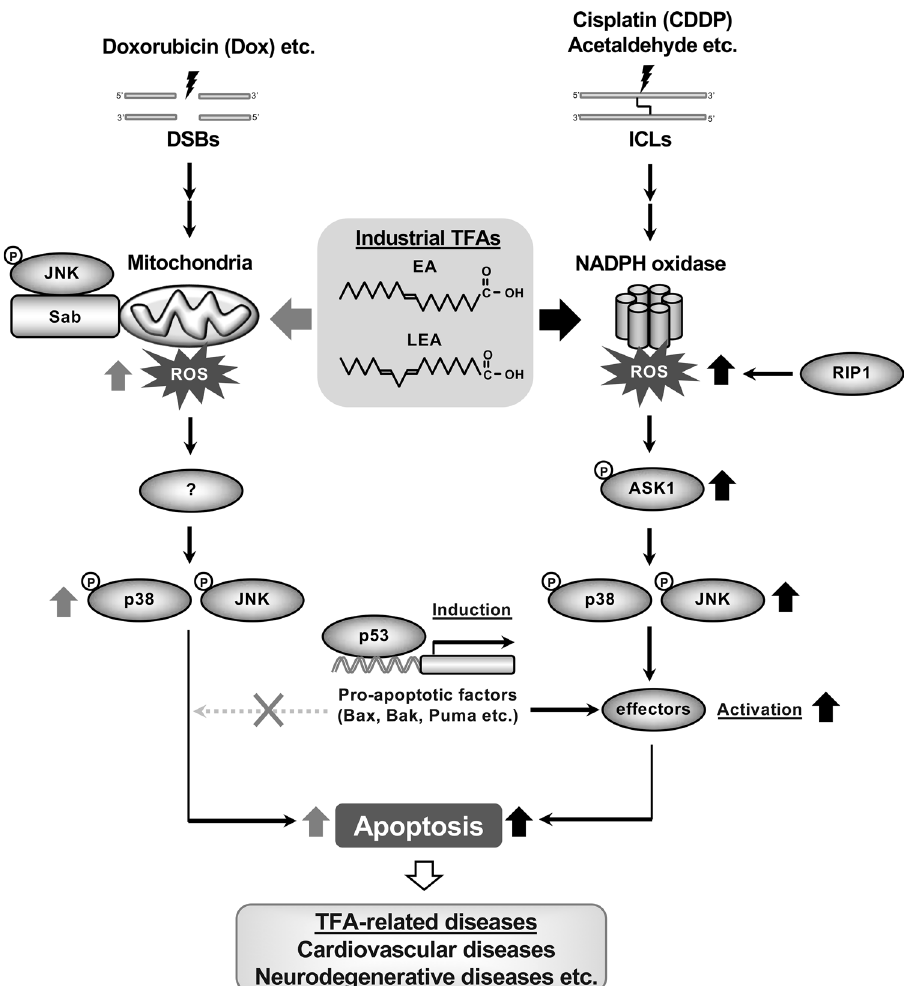
Figure 6. A schematic model for two distinct EA-mediated pro-apoptotic signaling pathways in response to DNA damage. Industrial TFAs such as EA and LEA promote cell death triggered by Dox (a DSB-inducing agent) and CDDP (an ICL-inducing agent) through two distinct pro-apoptotic signaling pathways. Upon Dox exposure, TFAs enforce mitochondrial ROS generation via the mitochondrial JNK-Sab (a JNK adaptor protein localized at outer membrane of mitochondria) axis, which in turn enhance JNK/p38 MAPK activation, and consequently promote apoptosis independently of ASK1 and p53 12 . On the other hand, upon CDDP exposure, TFAs drive Nox/RIP1-dependent ROS generation, and thereby enhance activation of the ASK1-p38/ JNK MAPK pathway, leading to increased p53-dependent apoptosis. The latter mechanism possibly accounts for TFA-mediated promoting effect on cell death induced by acetaldehyde, a major endogenous source of ICLs that accumulates by unhealthy lifestyle behaviors, such as cigarette smoking and alcohol drinking, or decreased acetaldehyde metabolism. Through these mechanisms, TFAs may contribute to the development and progression of TFA-related diseases, including cardiovascular diseases and neurodegenerative disorders, closely related to DNA damage along with individual difference in lifestyle factors and acetaldehyde